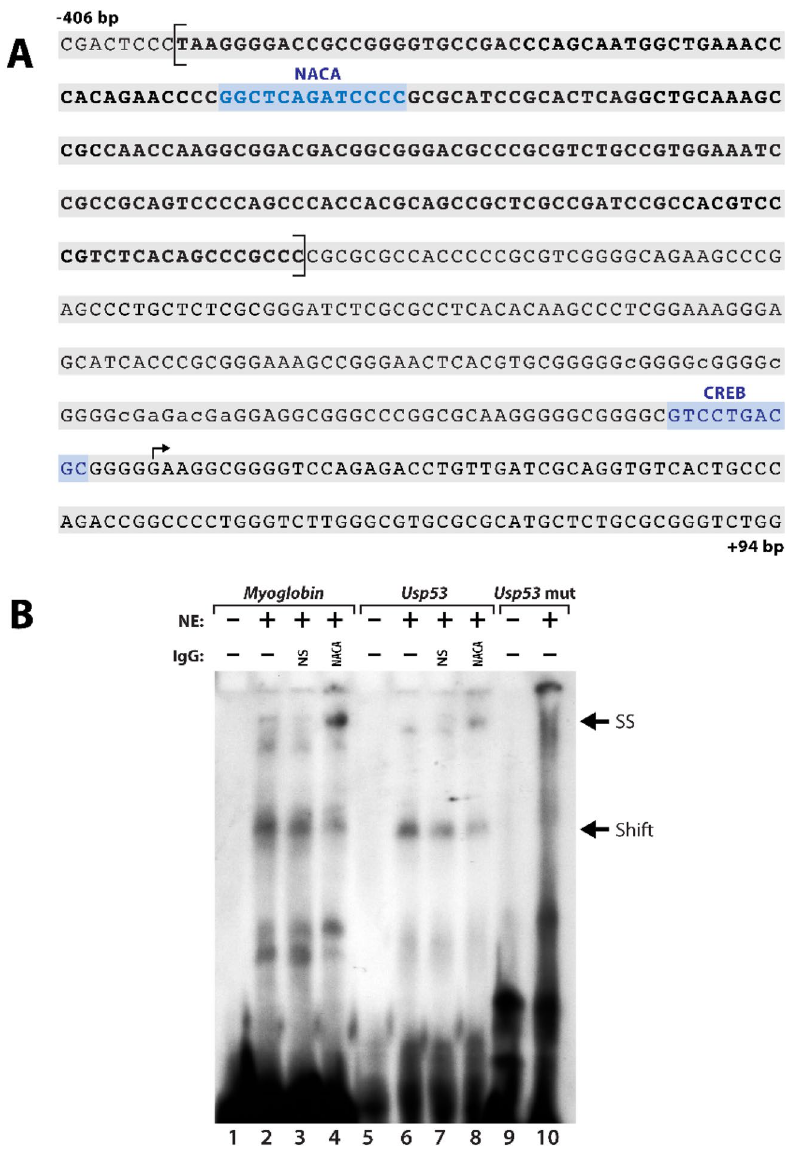
Figure 2. The proximal promoter of Usp53 contains binding sites for NACA and CREB. ( A ) Mouse Usp53 promoter sequence from nucleotide − 406 to nucleotide + 94 relative to the transcriptional initiation site (arrow). Nucleotides corresponding to the peak identified by ChIP-Seq are bracketed and in bold. Putative binding sites for NACA and CREB (highlighted) were called using Mat Inspector (Genomatix software suite). ( B ) Electrophoretic mobility shift assay (EMSA) analysis showing the binding of NACA to its binding site in the Usp53 promoter. EMSA was performed using probes harboring the NACAbds sequence present in the Myoglobin (lanes 1–4) or the Usp53 promoter (lanes 5–8), or a probe with a mutated NACAbds sequence present in the Usp53 promoter ( Usp53 mut; lanes 9 and 10). Nuclear extracts (NE) proteins from HEK293 cells overexpressing NACA and treated with 6Bnz-cAMP to induce nuclear translocation were incubated with the probes. Negative binding was assessed by incubating the probes with the binding buffer (lanes 1 and 5). The black arrow (Shift; bottom arrow) indicates the generation of a slower migrating EMSA product, the resultant of NACA binding to NACAbds sequences in both the Myoglobin and Usp53 probes. Addition of anti-NACA antibody led to an additional supershift complex (SS; top arrow), not detected when adding naive non-specific (NS) IgG to the binding